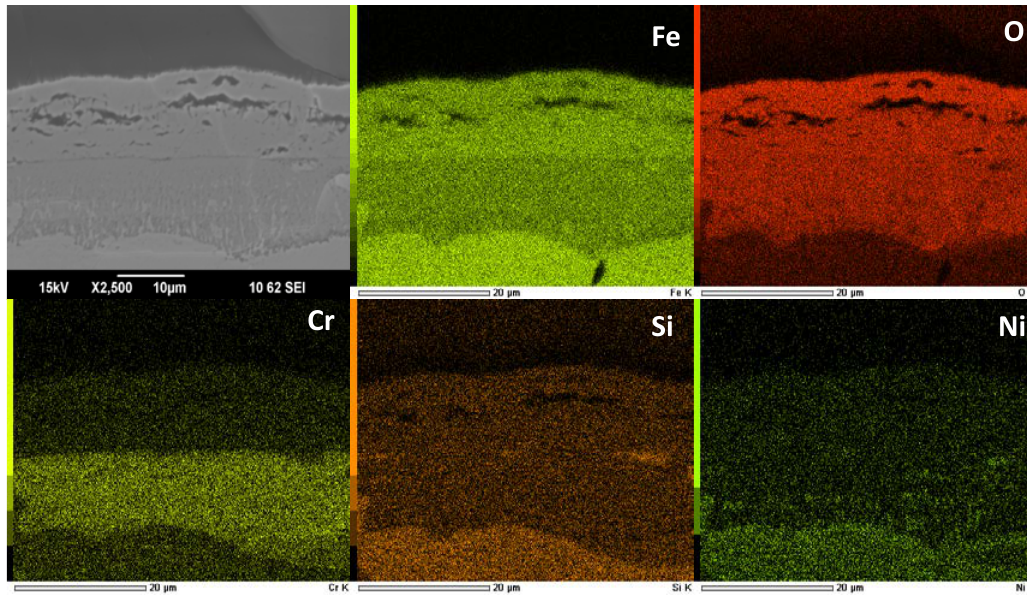
Figure 8. SEM X-ray maps of the IC oxidized at 700 °C in humid air.